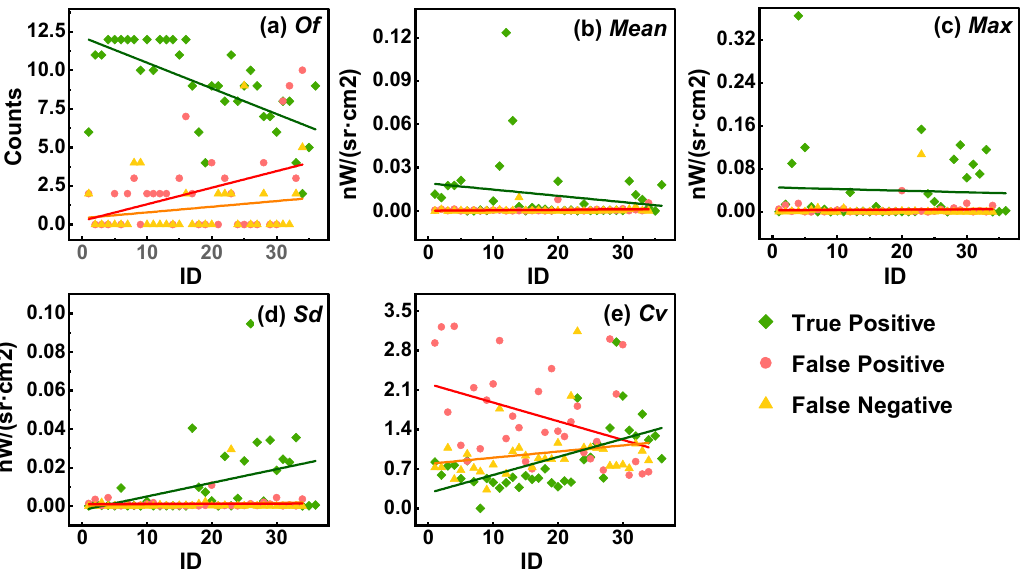
Figure 11. Feature distribution of each target in 2017: ( a ) is the occurrence frequency distribution; ( b ) is the mean distribution; ( c ) is the maximum distribution; ( d ) is the standard deviation distribution; and ( e ) is the coefficient of variation distribution. The green diamond indicates the correctly extracted targets, the red circle is the incorrectly extracted targets, and the yellow triangle is the omissive targets. The green line is the fitted line of the feature distribution for the correct targets; the red line is the fitted line of the feature distribution for the incorrect targets, and the orange line is the fitted line of the feature distribution for the omissive targets.